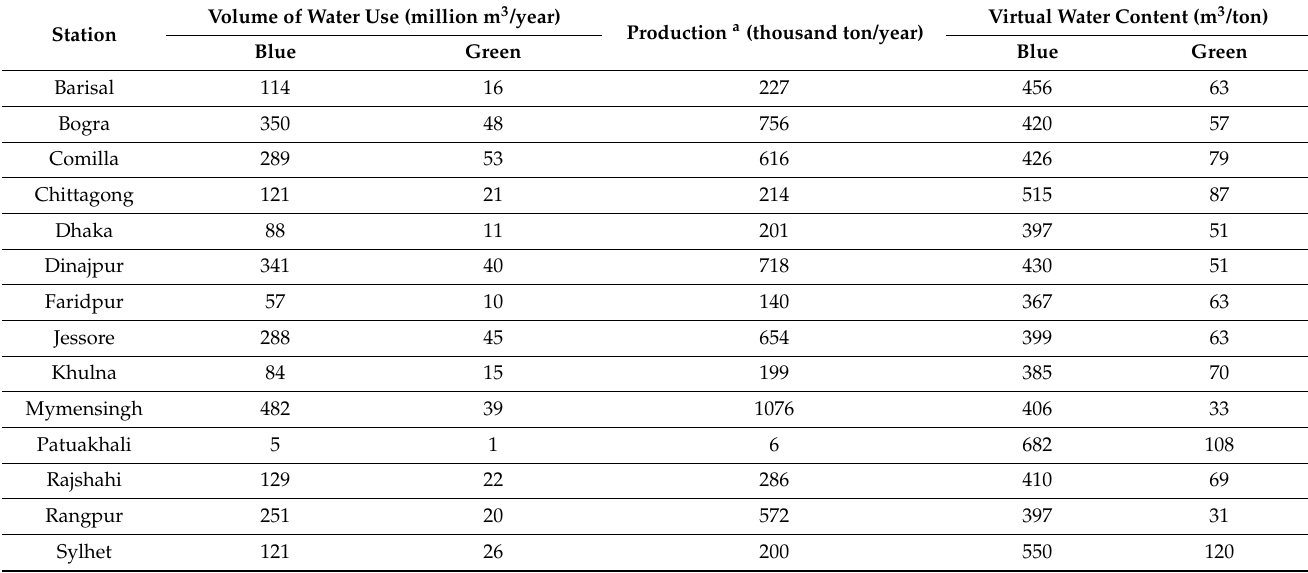
Table A3. Blue water footprint and green water footprint of rice in